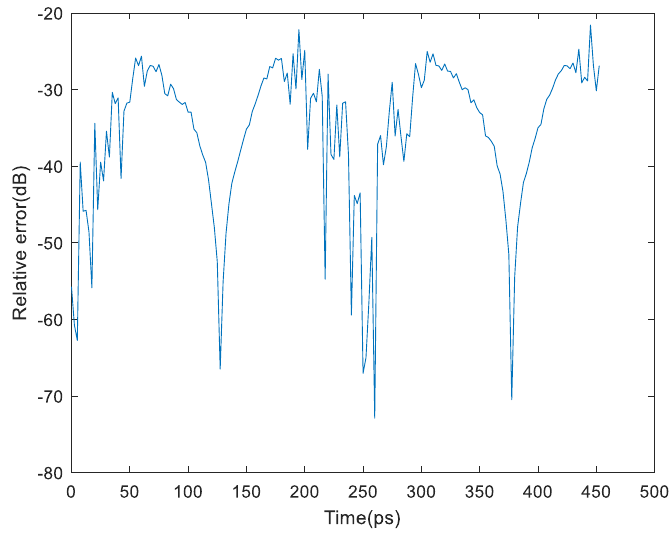
Figure 10. Relative error between the HTBF method and the physical model method.